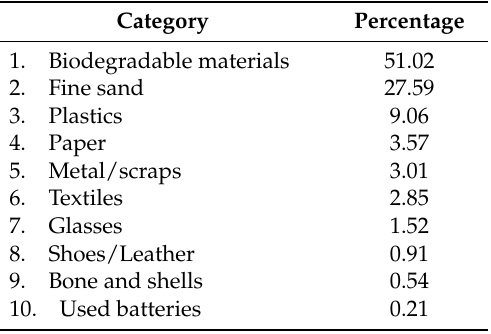
Table 1. Household waste characterisation (adapted from Tchakpa et al. (2012) [17]).